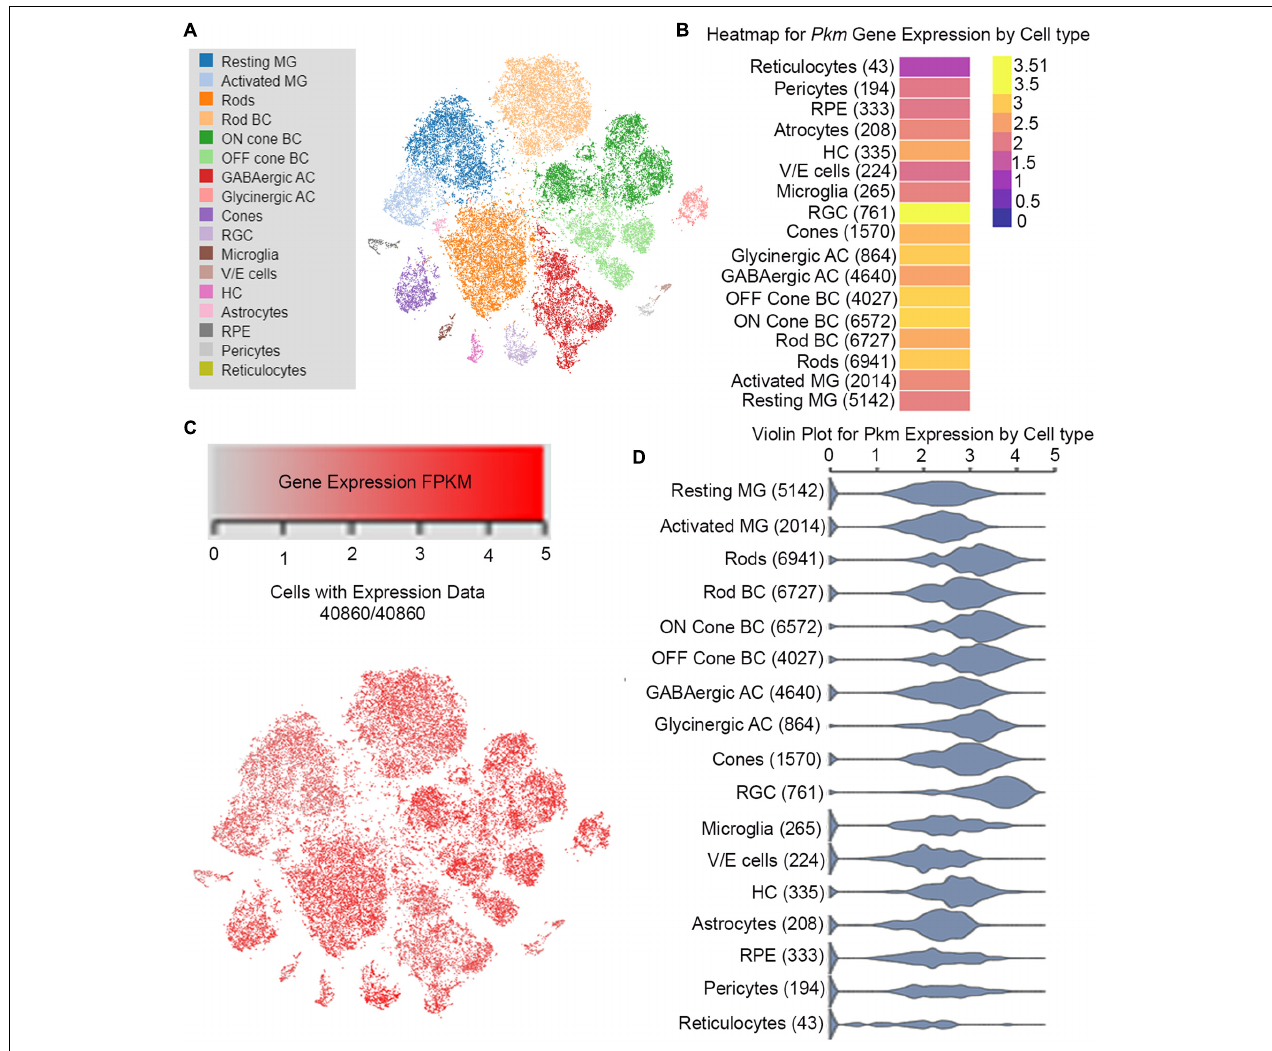
FIGURE 3 | Cell-specific Pkm expression in adult mouse retina on single-cell RNA-seq analysis. From this publicly available database https://proteinpaint.stjude. org/F/2019.retina.scRNA.html, we searched the Pkm gene expression in various cell types of the retina from single-cell RNA-seq analysis (A) . t-distributed stochastic neighbor embedding (t-SNE) plots of gene expression distribution in adult mouse retina (B) . Each dot represents a single cell. Levels of gene expression of Pkm in different cell types (C) . FPKM: Fragments/Kilobase of transcript per Million mapped reads. Violin plots showing expression levels Pkm gene in different cell types of the mouse retina (D)